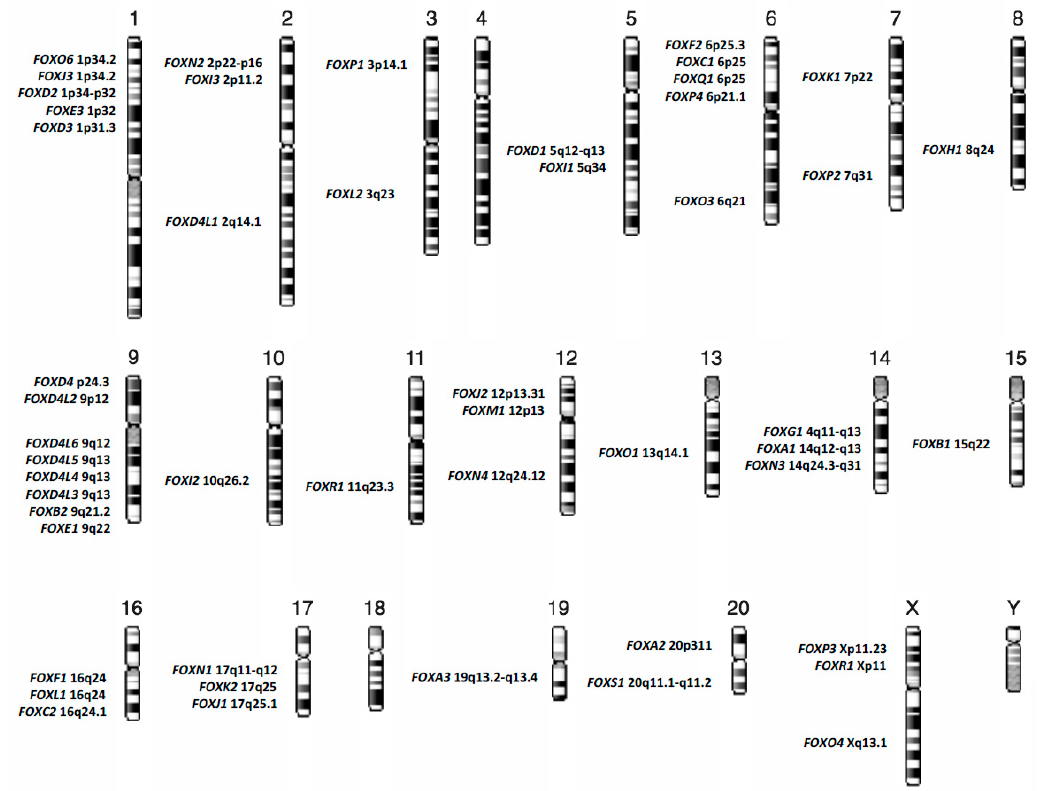
Figure 1. Chromosomal distribution of forkhead box ( FOX) genes in the human genome.